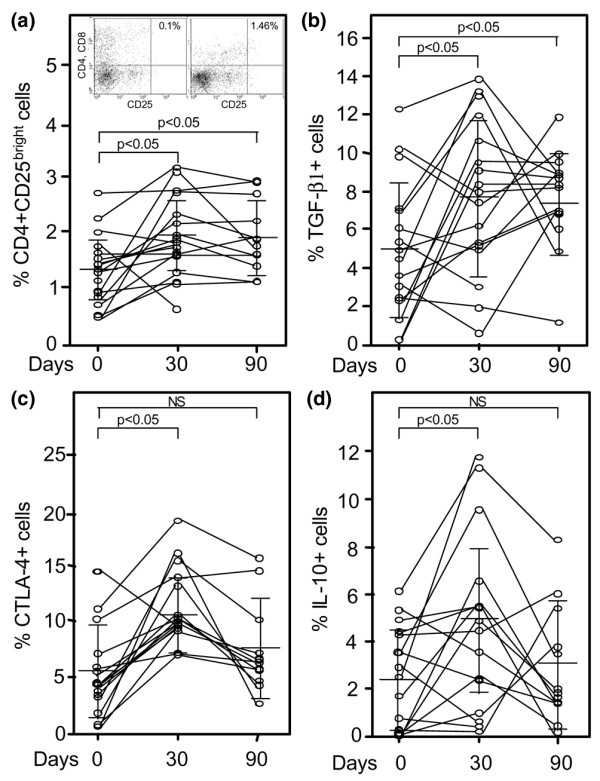
Effect of Rituximab therapy on the levels of peripheral blood regulatory T cells. In 17 systemic lupus erythematosus patients that received Rituximab (0.5 to 1.0 g at days 0 and 15), the levels of (a) CD4+CD25bright and (c) CD4+CTLA-4+ cells, and CD4+ lymphocytes synthesizing (b) TGF-β+ or (d) IL-10 was assessed in peripheral blood by flow cytometry before (day 0), and at days 30 and 90 of Rituximab therapy, as described in Materials and methods. The inset in (a) shows how the expression of CD25 by activated CD8+ cells (left histogram) was employed to define CD4+CD25bright cells (right histogram). The arithmetic mean is indicated with a horizontal line, and the standard deviation with a vertical line. In all cases, the percentage of positive cells is referred to the gate of lymphocytes, defined by side and forward scatter characteristics.